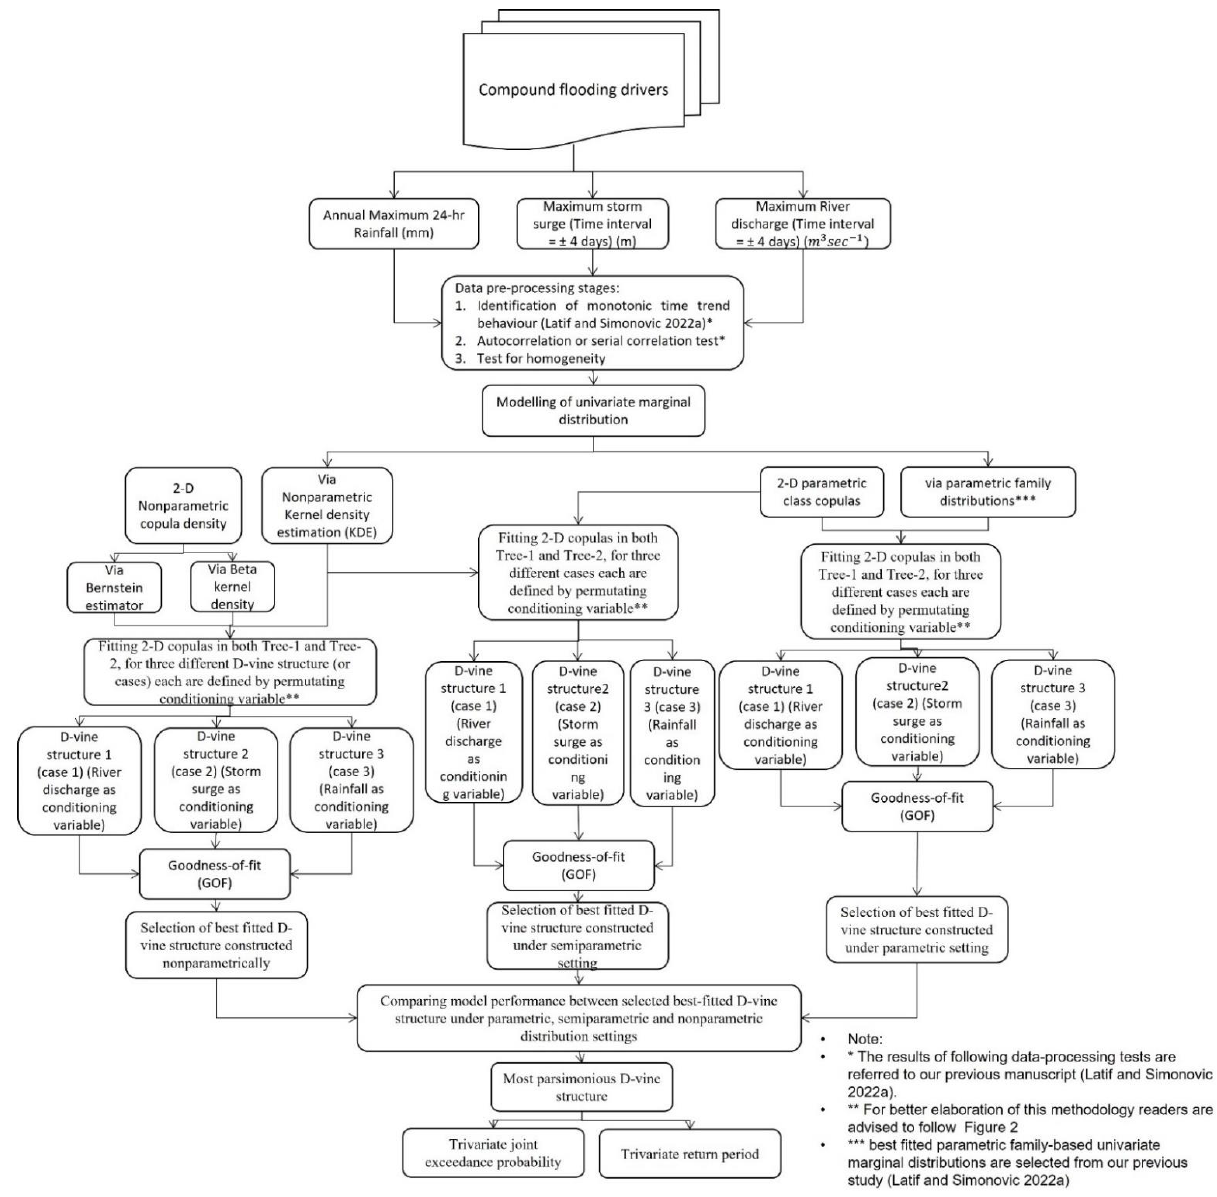
Figure 1. Workflow chart of the present study.